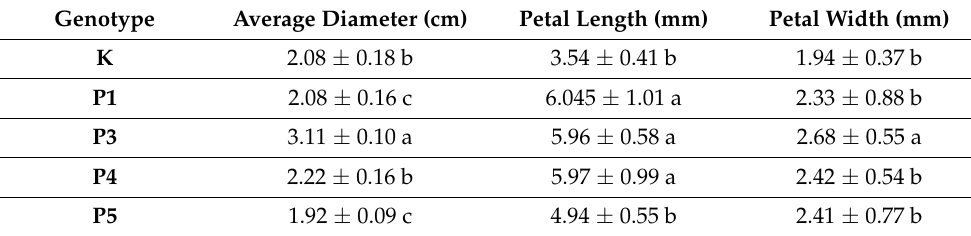
Table 3. Morphological characteristics of flowers of diploid and autotetraploid